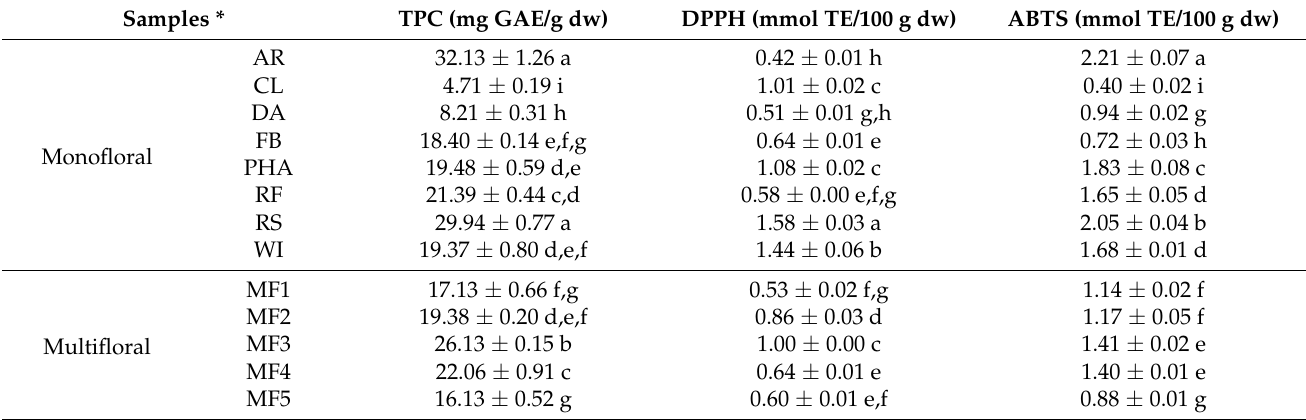
Table 2. Total phenol content and antioxidant activity of monofloral and multifloral bee pollen. Samples